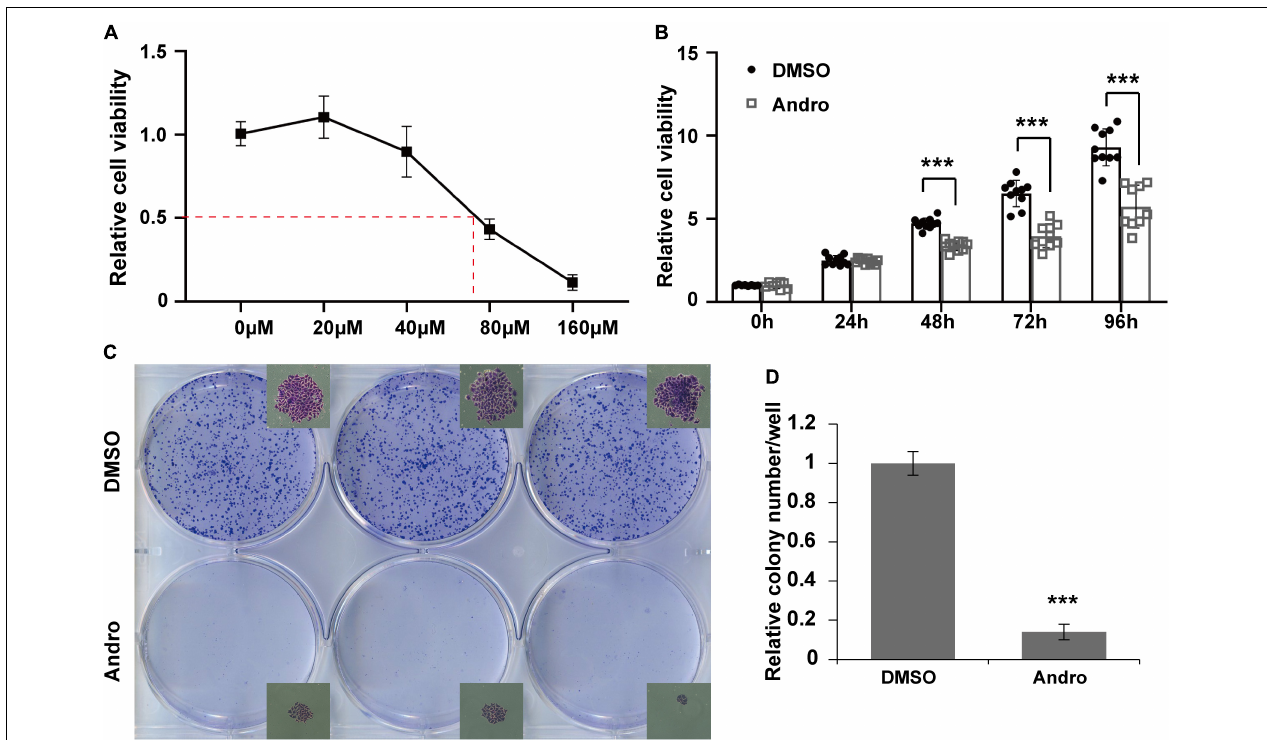
FIGURE 4 | Andrographolide (Andro) inhibits viability and proliferation of MCF-7 cells. (A) Dose-dependent effect of andrographolide (Andro) on MCF-7 cell viability at 48 h (IC 50 = 70 µ M). (B) Treatment duration effect of Andro (70 µ M) on MCF-7 viability. (C) Colony formation assay. (D) Colony counts. Quantitative data are expressed as the mean ± SD ( n = 3). Significant effect: *** P <